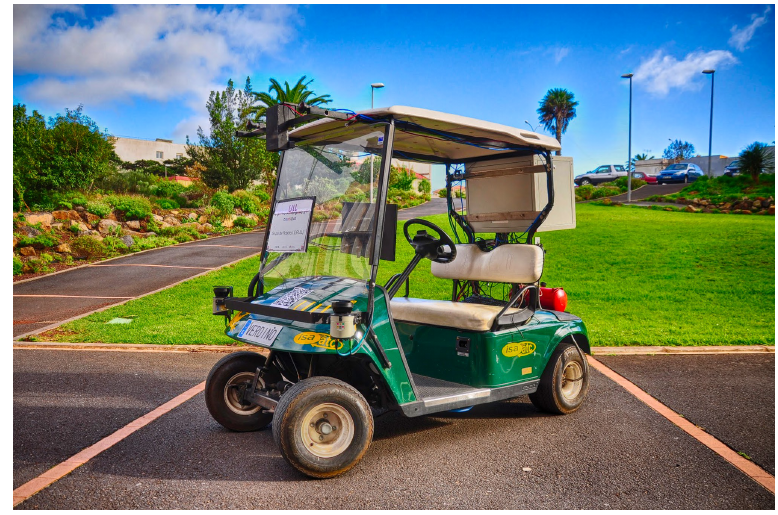
Figure 1. The sensors system to measure cart speed.